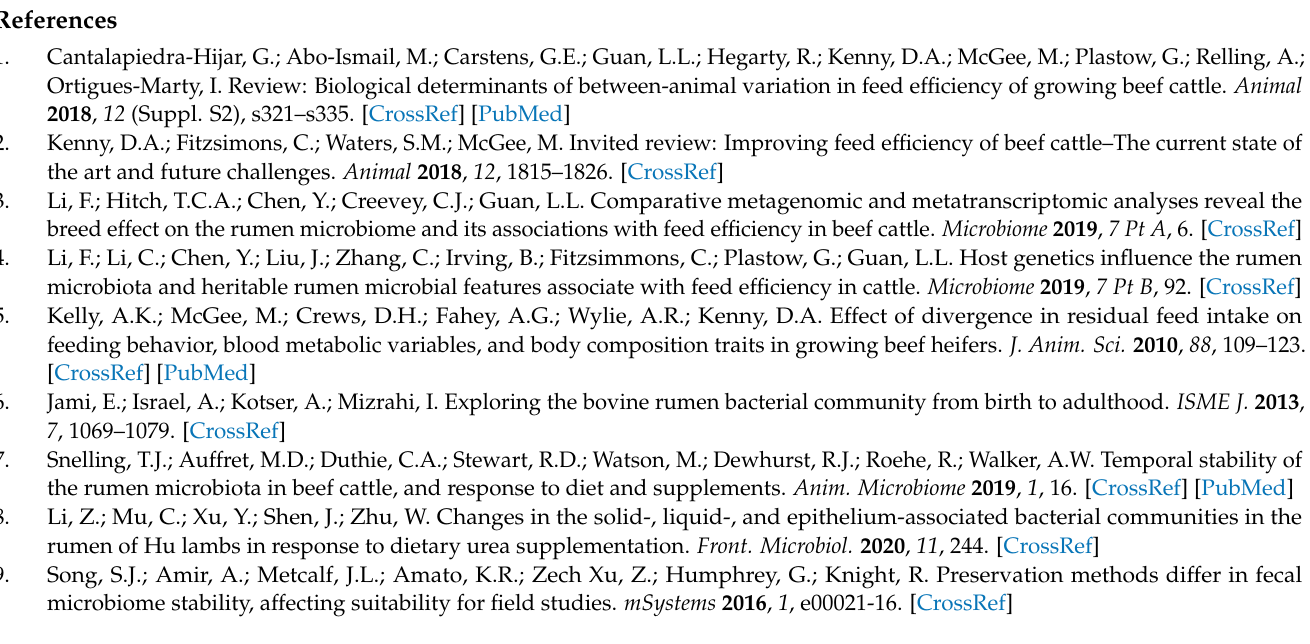
HRFI, with Table S3: Summary of statistical results at the class level, Table S4: Summary of statistical results at the order level, and Table S5: Summary of statistical results at the genus